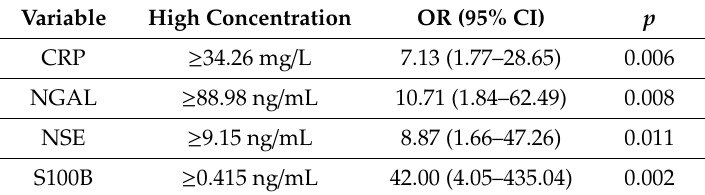
Table 5. High concentrations of the investigated biomarkers and ICU mortality 1 .